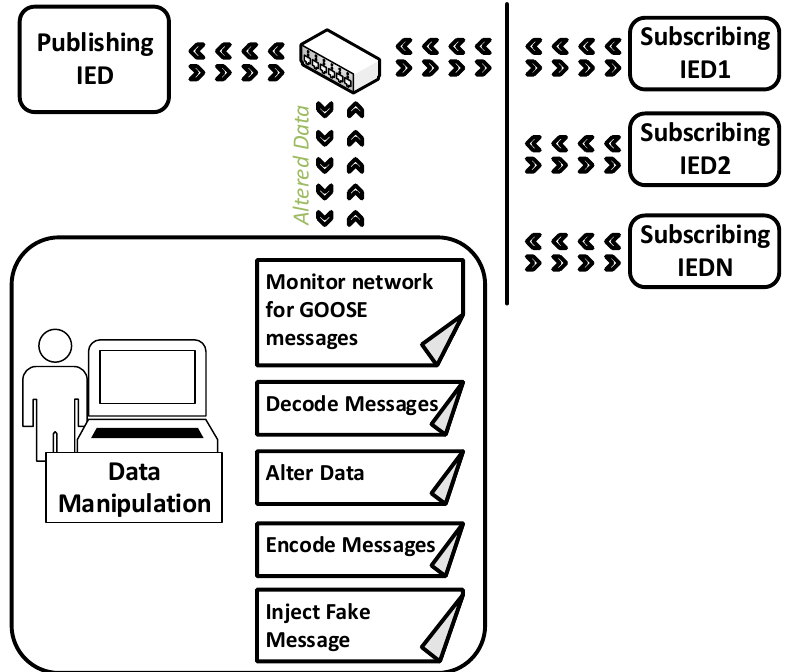
Figure 6. GOOSE Messages Data Manipulation Overview.